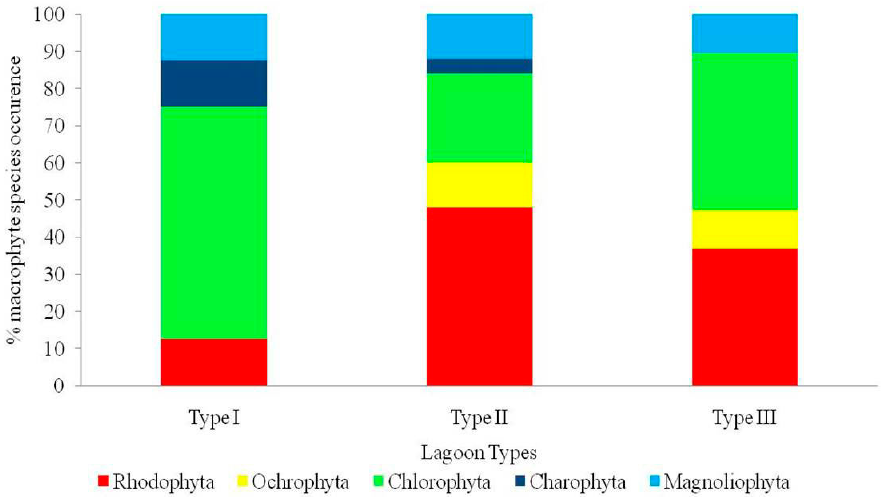
Figure 3. Percentage of macrophyte species occurrence in the three different lagoon types of Western Greece.